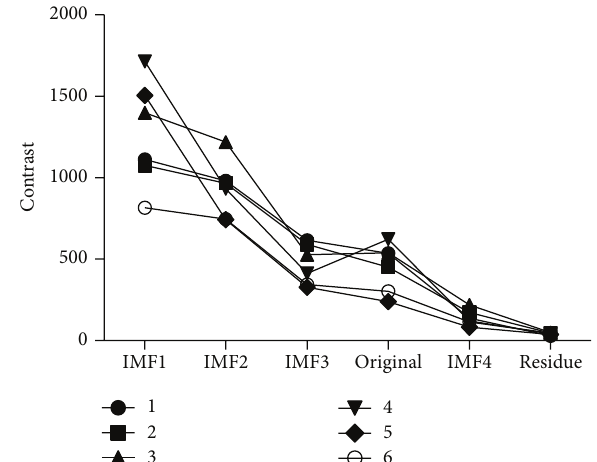
Figure 3: Contrast comparison of IMFs, residue and original